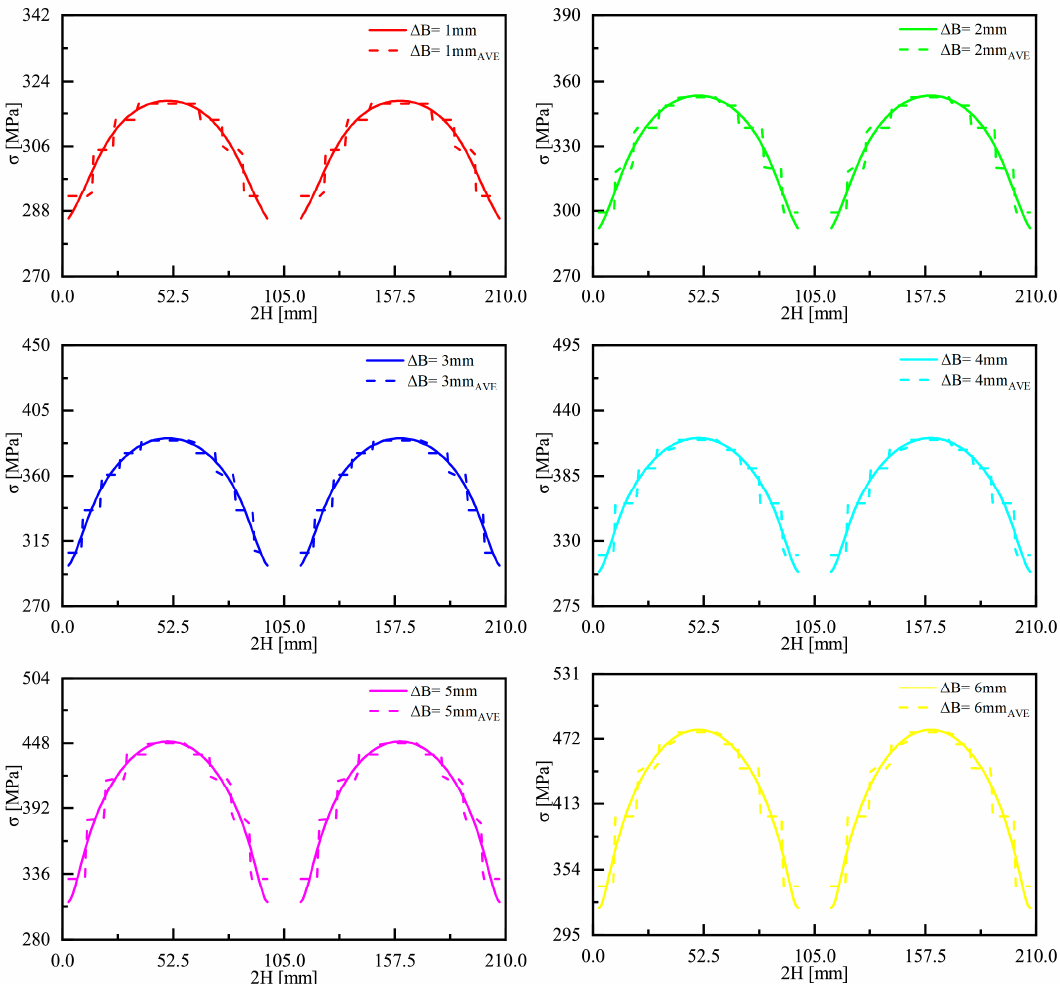
Figure 14. Average yield points (dotted lines) defined according to the bulging calculations (Figure 13a) indicated by the solid lines.